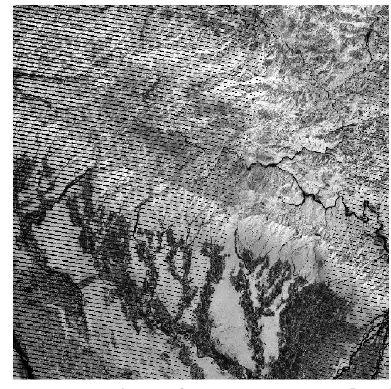
Figure 2. Subset of NDVI array visualized